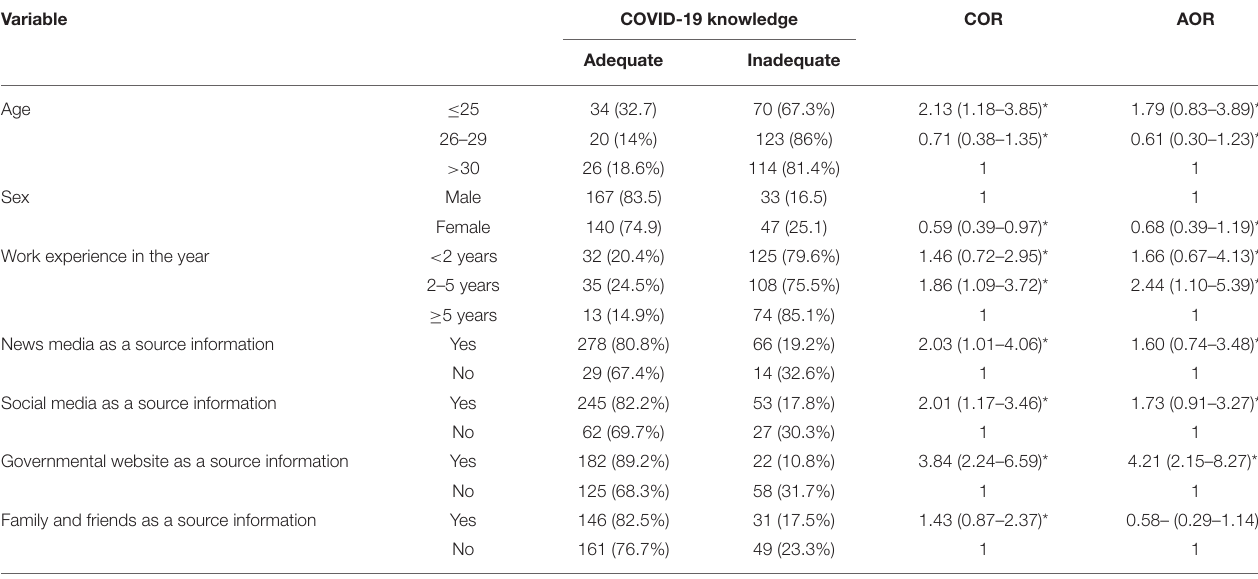
TABLE 2 | Univariate and multivariate logistic regression analyses of knowledge about COVID-19 among health workers at Aksum University Comprehensive and Specialized Hospital (AKUCSH) and Saint Mary’s General Hospital in Tigray Regional State of Northern Ethiopia ( n = 403), April to May 2020. Variable